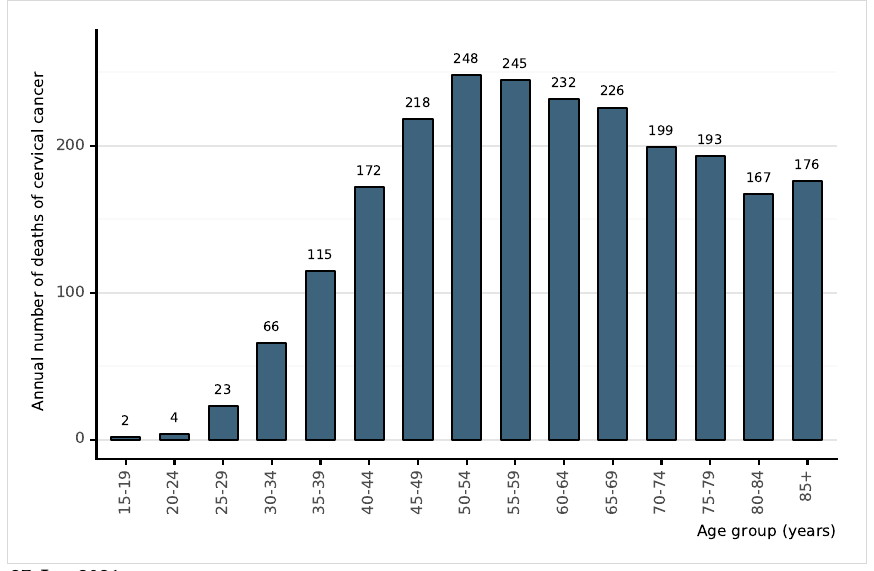
Figure 12: Annual number of deaths of cervical cancer in Peru (estimates for 2020)